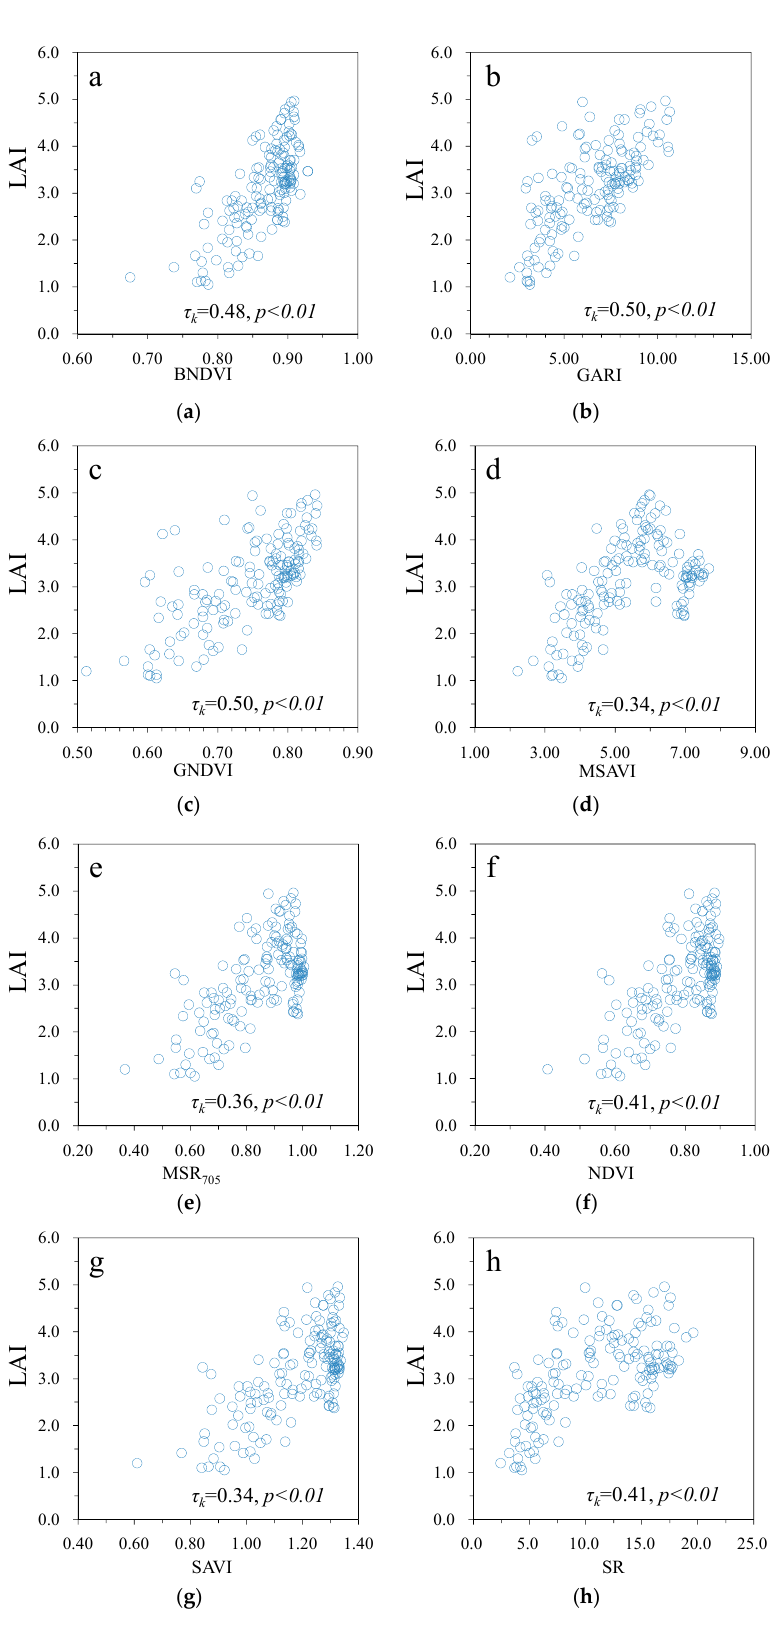
Figure 5. Correlation between LAI and the selected vegetation indices from imaging spectroscopy data: ( a ) BNDVI, ( b ) GARI, ( c ) GNDVI, ( d ) MSAVI, ( e ) MSR 705 , ( f ) NDVI, ( g ) SAVI, ( h ) SR. Kendall’s correlation coefficient τ k and the significance level p are given in each plot.